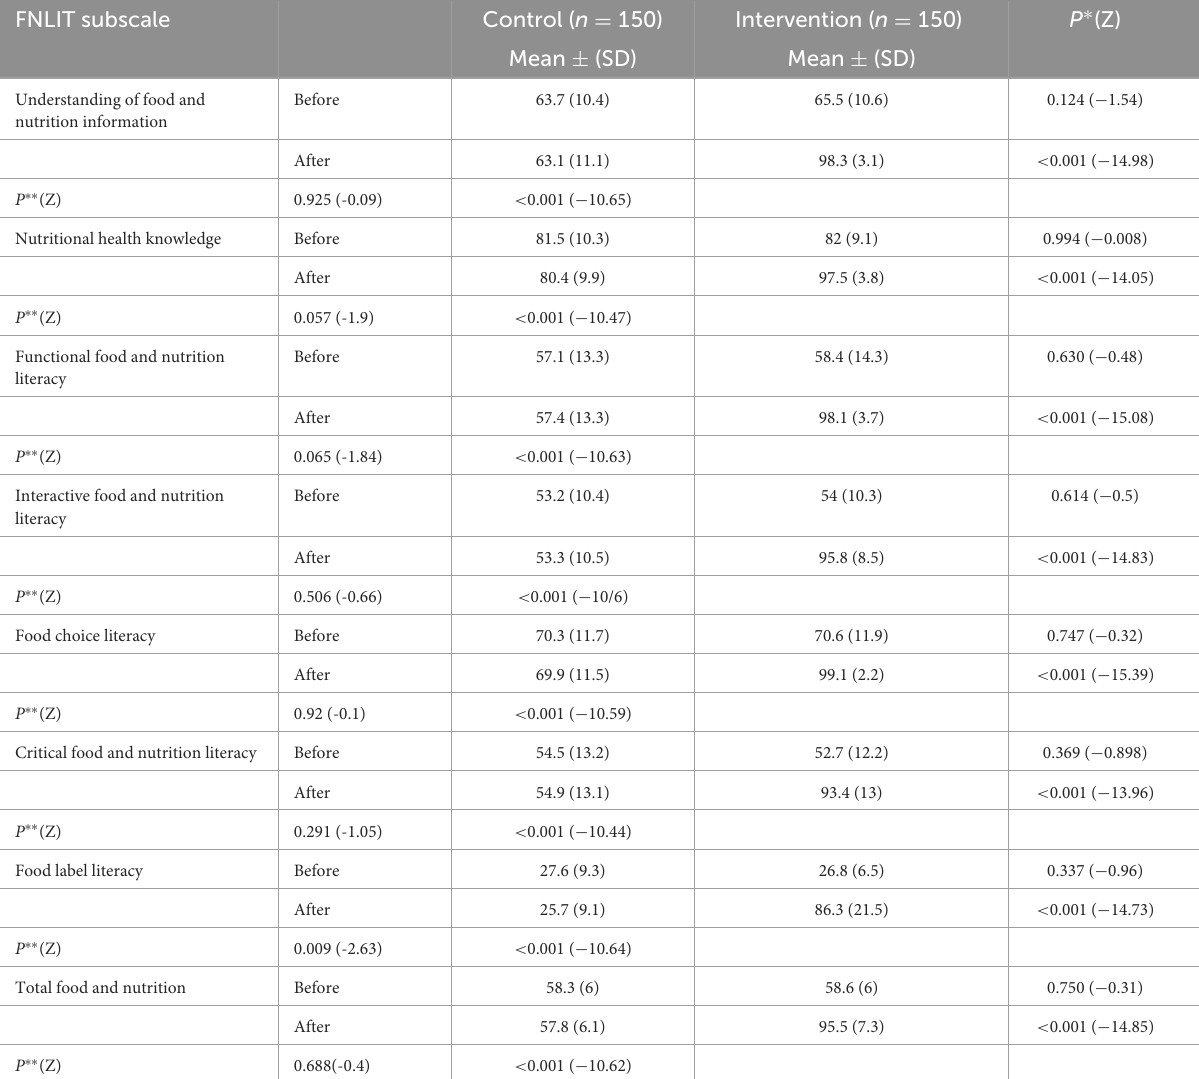
TABLE 5 Mean and standard deviation scores of FNLIT subscales in both control and intervention groups. FNLIT subscale Control ( n =